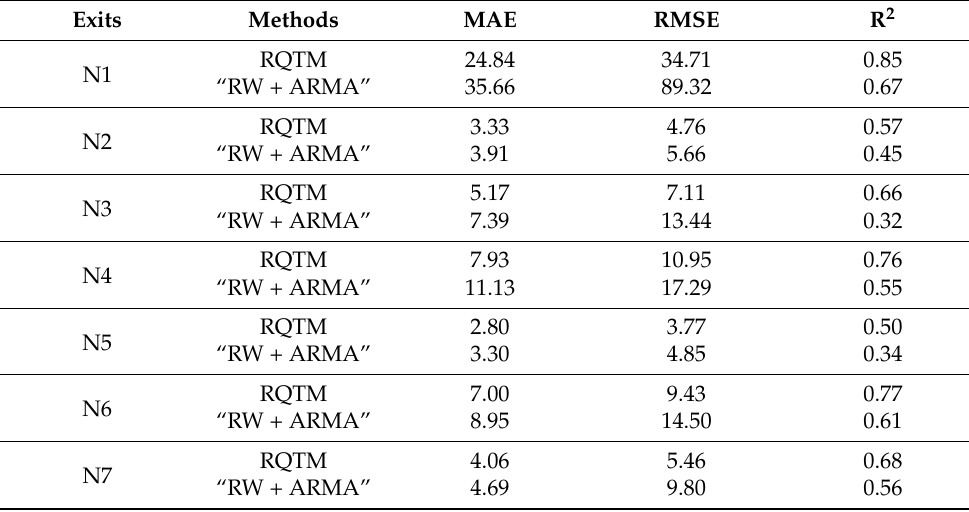
Table 4. Statistics of the model performance of RQTM and “RW +